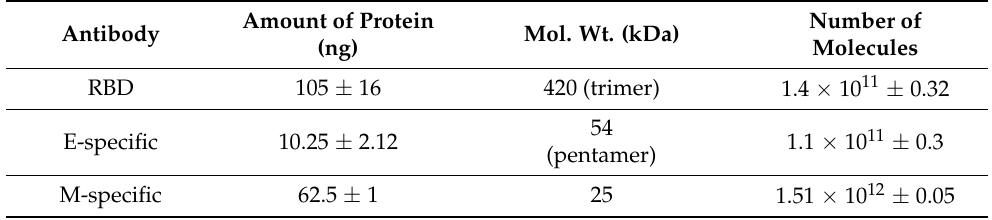
Table 1. Concentration of S, E, and M protein in PRAK-03202.